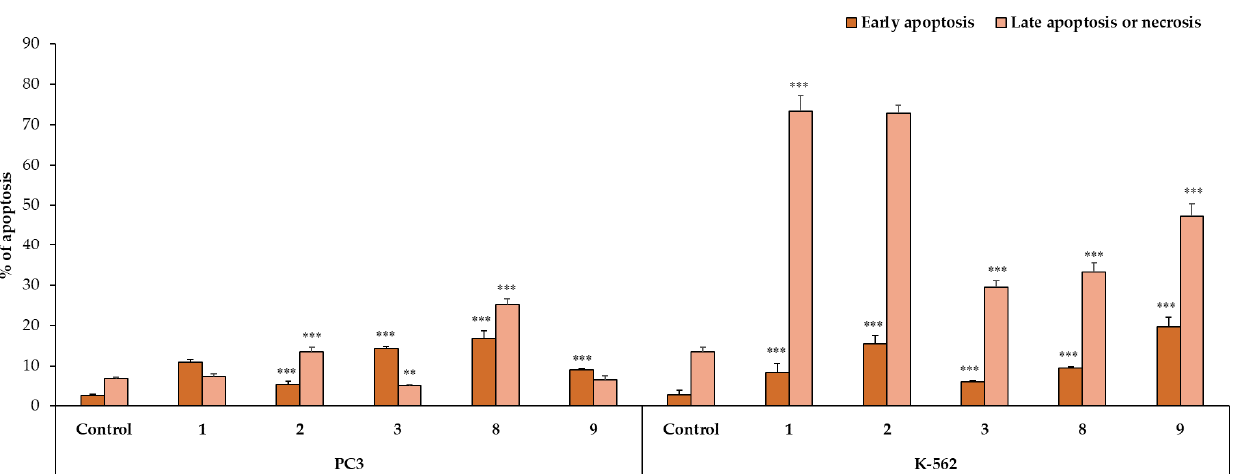
Figure 2. The effect of compounds 1 – 3 , 8 , and 9 on early and late apoptosis in SW480, SW620, and HaCaT cells. Cells were incubated for 72 h with the tested compounds used in their IC 50 concentrations, then cells were harvested, stained with Annexin V-FITC and PI, and analyzed using flow cytometry. Data are expressed as % of cells in the early stage of apoptosis, and as % of cells in the late stage of apoptosis or necrosis. Data are expressed as the mean ± SD. *** p ≤ 0.001, ** p ≤ 0.01, as compared to the control.